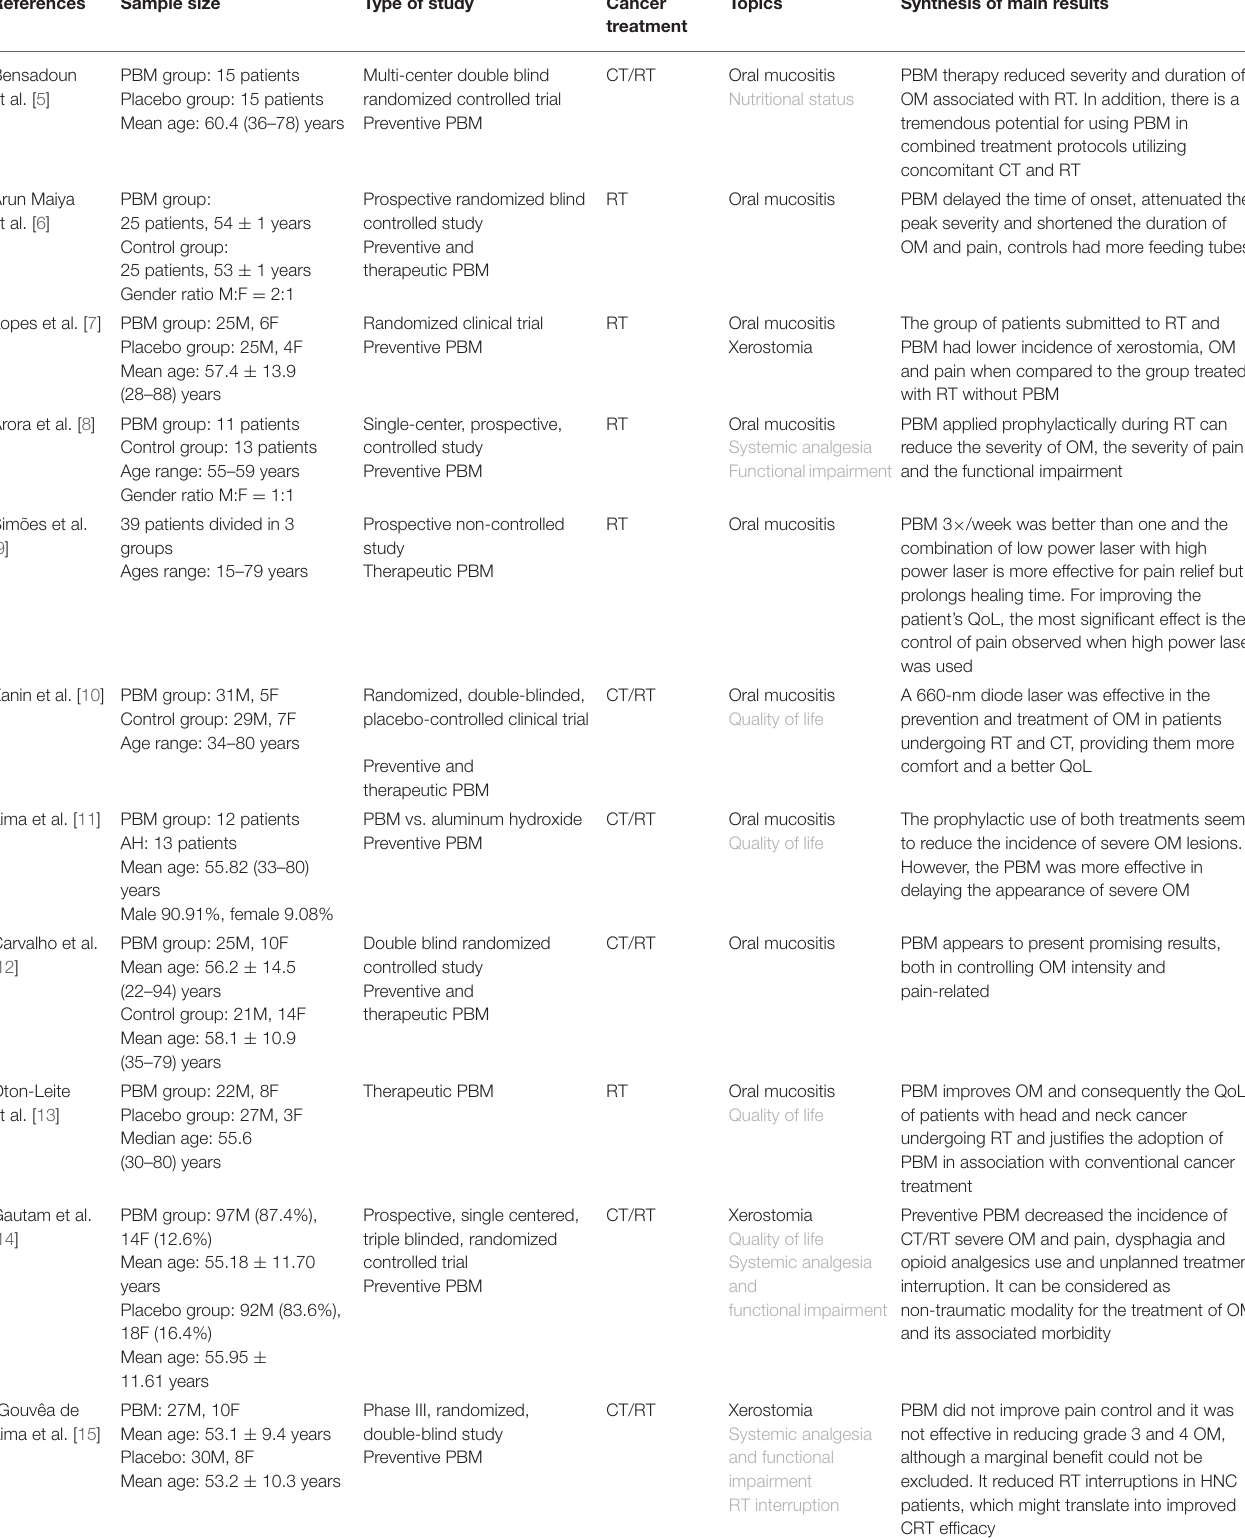
TABLE 1 | Characteristics of studies included in the narrative